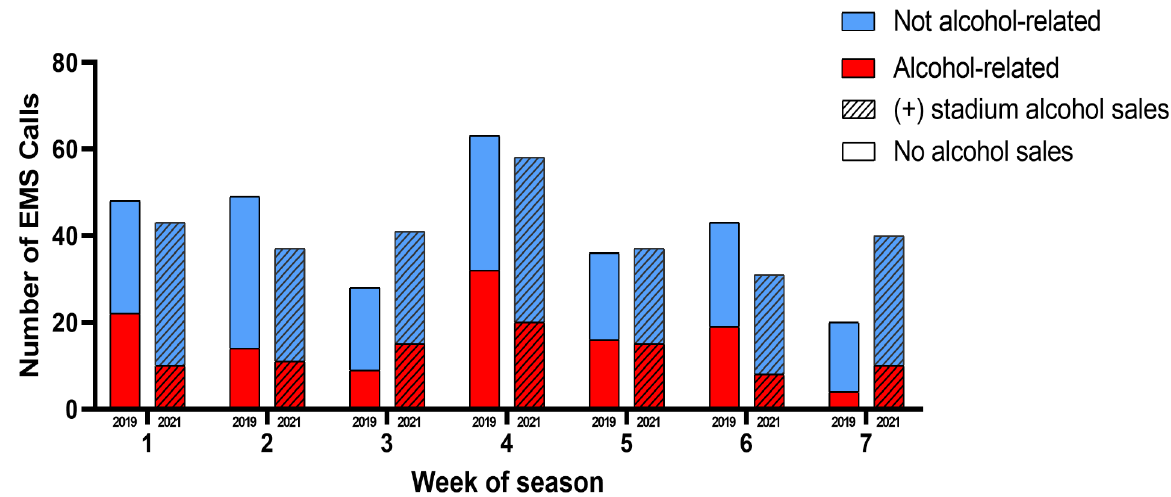
Figure 1. Number of emergency medical service calls on home game days, 2019 and 2021